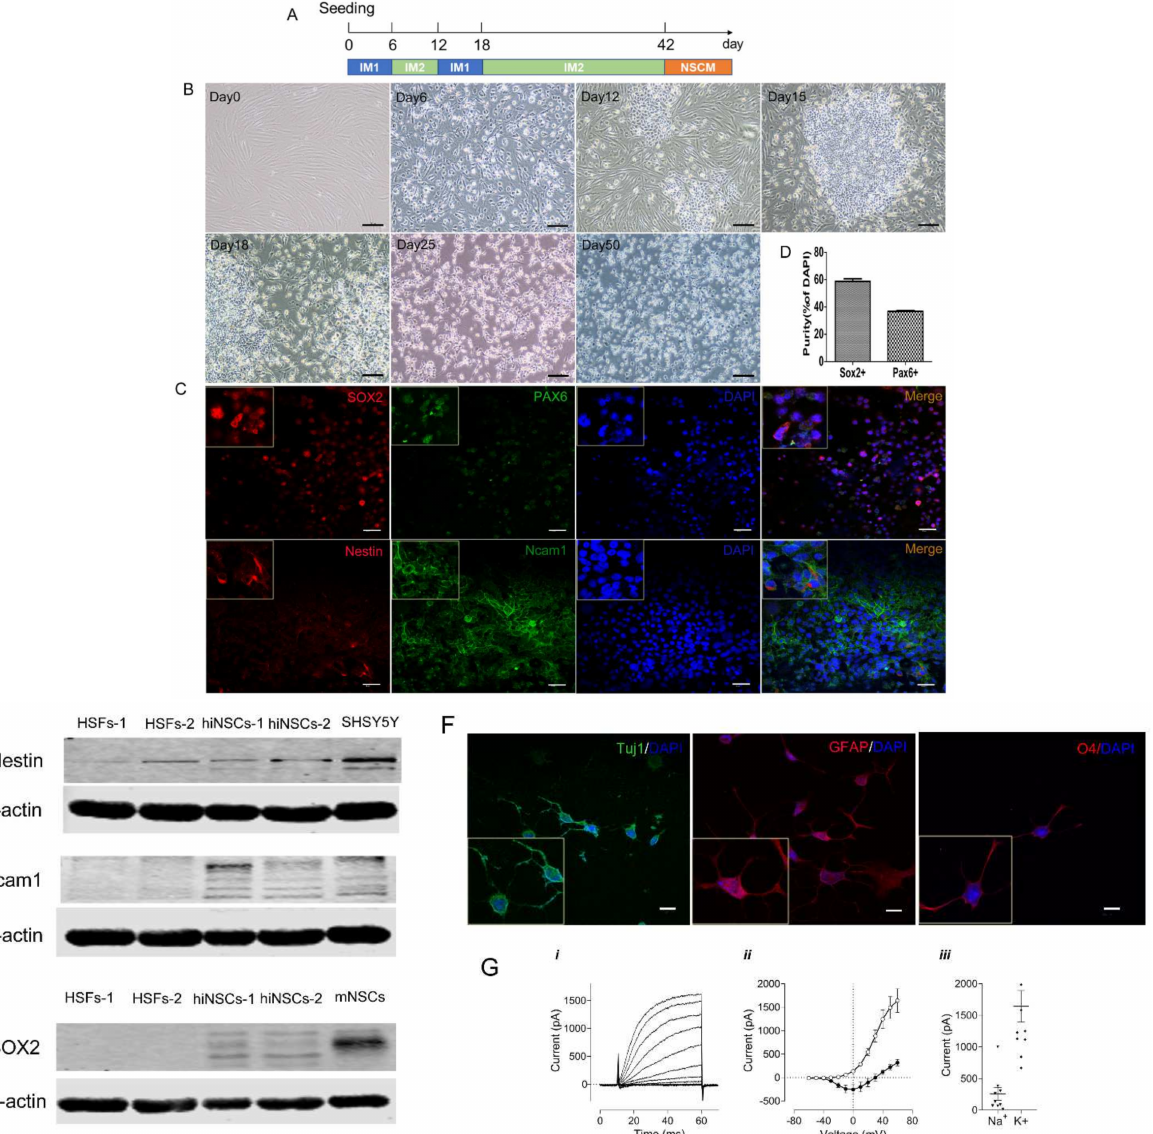
Figure 5. Generation of hiNSCs from another fibroblast cell line. ( A ) Scheme of induction procedure of hiNSCs-2. ( B ) Phase contrast images of cells during induction time, scale bars are 200 µ m. ( C ) hiNSCs-1 stained for neural stem cell makers, SOX2, Nestin, PAX6, and Ncam1, scale bars are 40 µ m. ( D ) The percentage of Sox2+ and Pax6+ cells in total cells at the time of quantification (means ± SEM, cell counting was from 3 triplicate samples) ( E ) Representative immunoblots for SOX2, Nestin (upper band), and Ncam1 in different cells, B-actin (beta-actin) was used as a loading control. ( F ) Differentiation of hiNSCs-2 in vitro, differentiated cells were immuno-positive for Tuj1, GFAP and O4 after 2–3 weeks culture in NDM, ADM, and ODM, respectively. ( G ) Electrophysiological properties of hiNSCs-2 derived neurons. i . Representative membrane currents recorded in hiNSCs-2 cell in response to the same voltage protocol as in Figure 4A. ii . Average current–voltage plots of the Na+ (solid symbols) and K+ (clear symbols) currents constructed using recordings similar to those shown in panels A ( n = 9). iii . Scatter plots of the absolute peak amplitudes of Na+ and K+ currents shown in panel ii. Data were from 2 cell